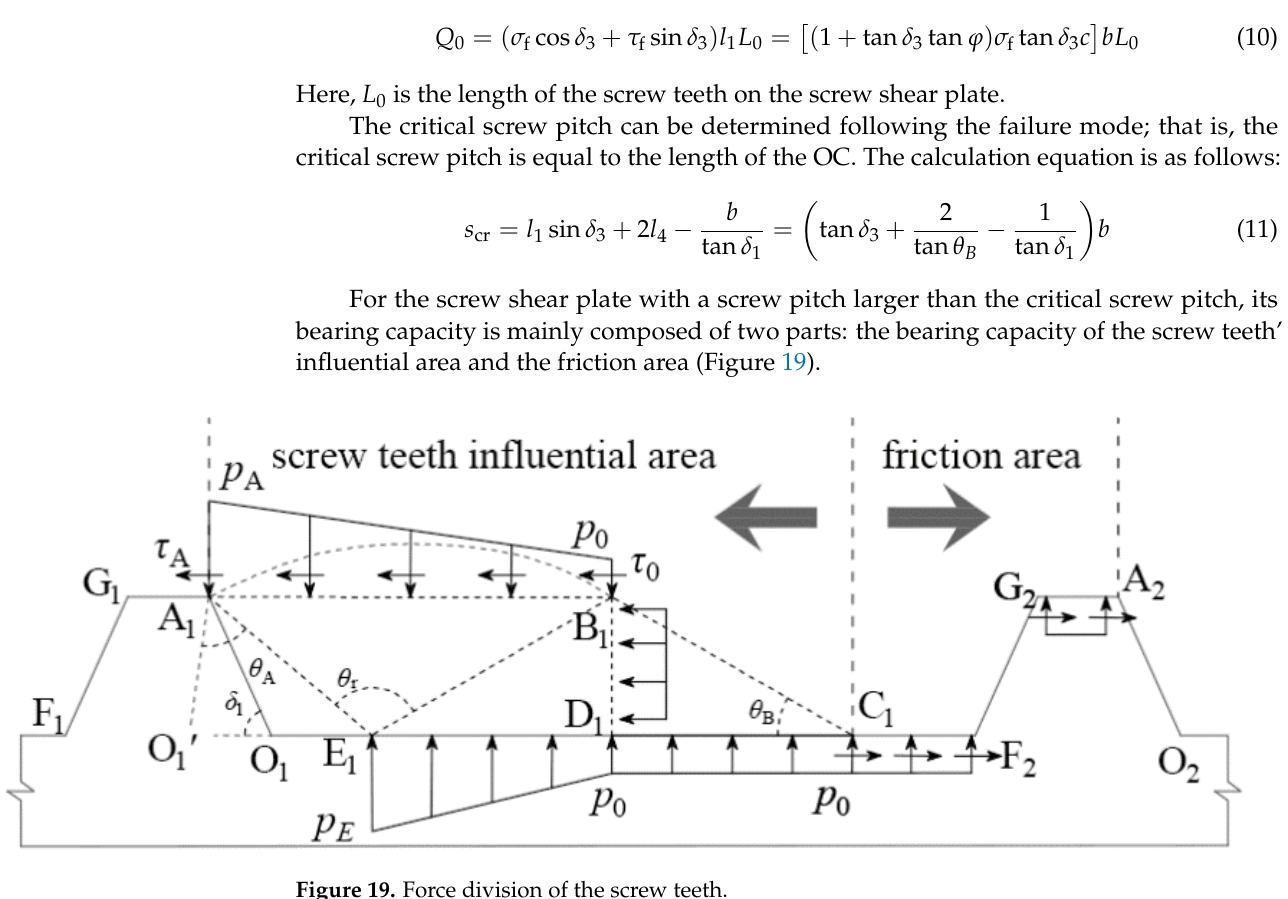
Figure 19. Force division of the screw teeth.